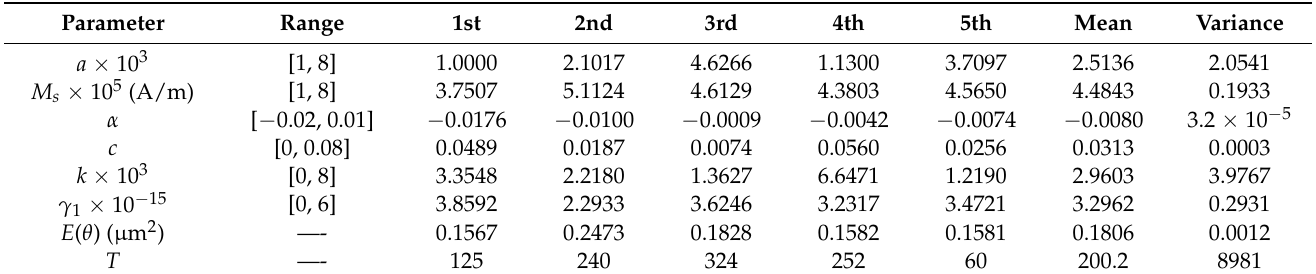
Table 1. Repeated identification results of the GA.